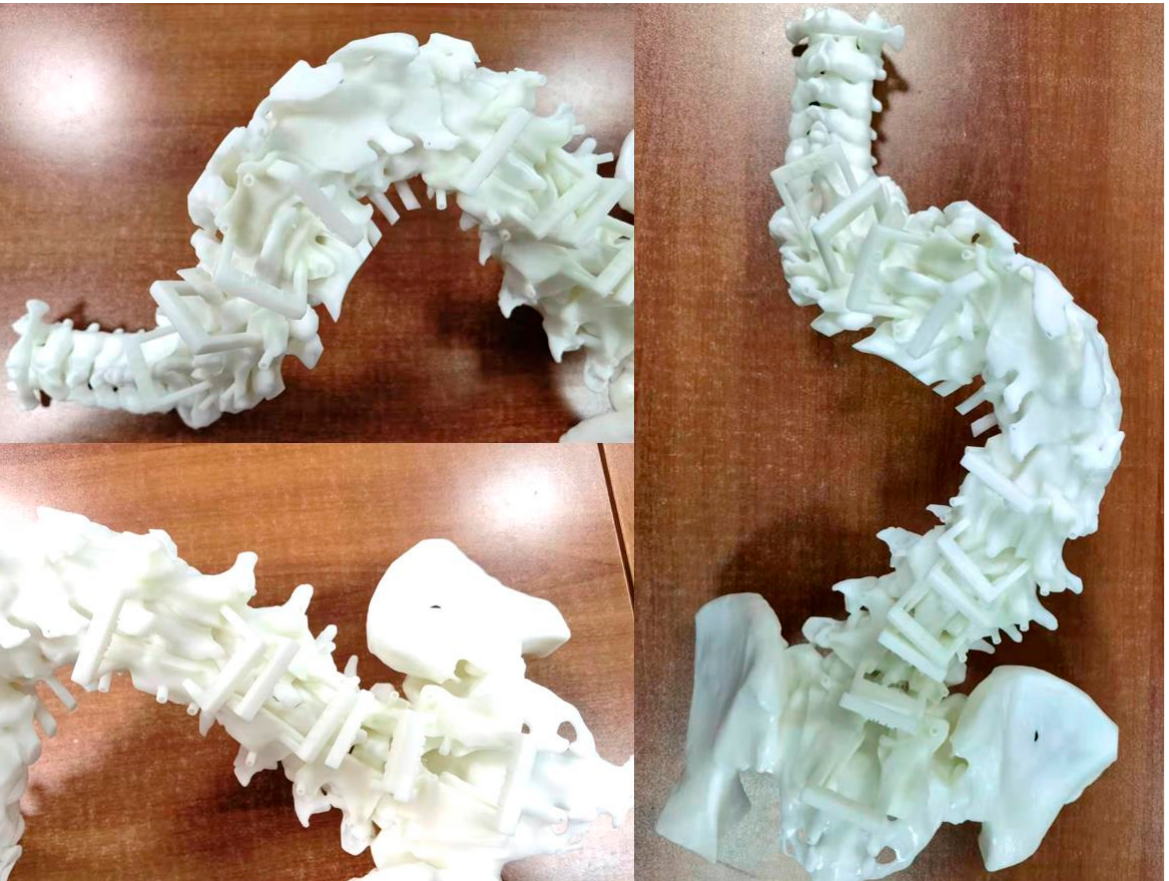
Figure 4. 3DP spine model and guidance templates.